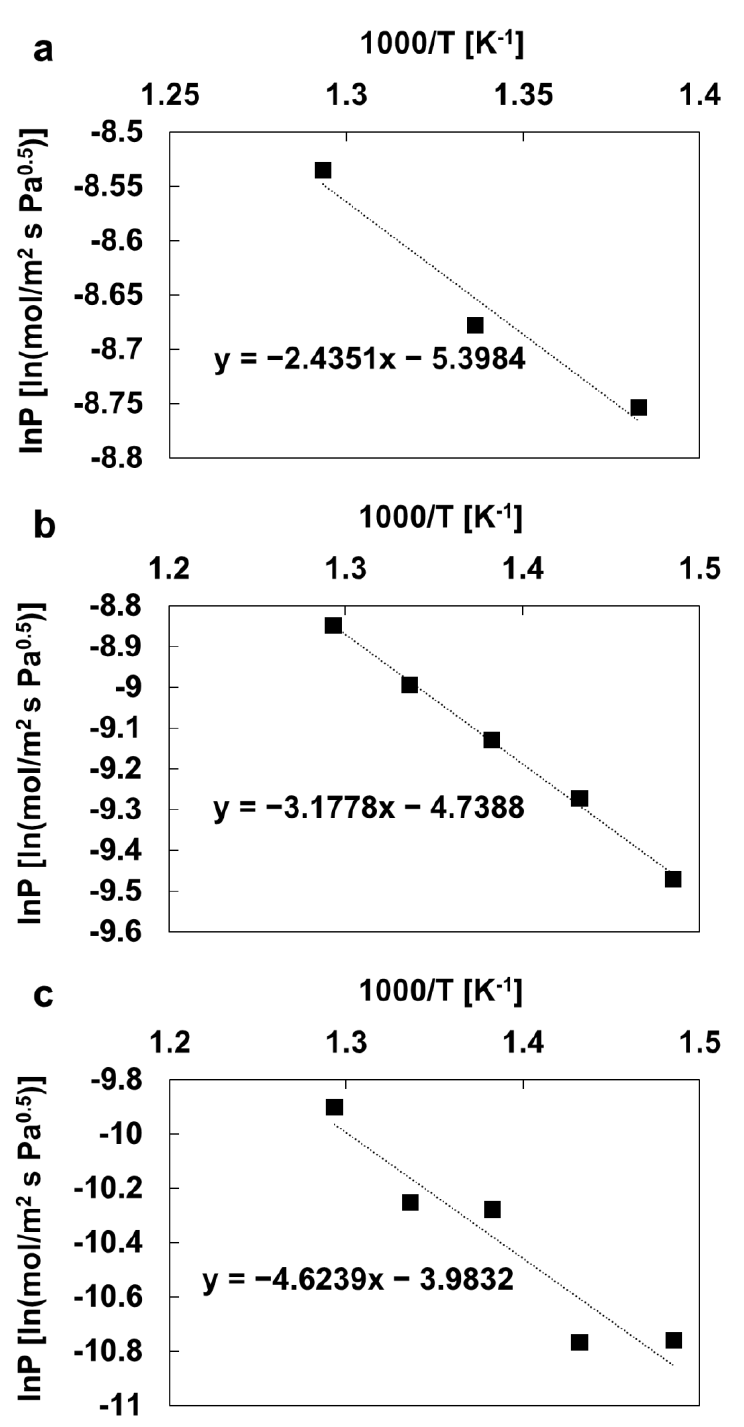
Figure 9. lnP vs. 1000/T of H 2 permeation test for ( a ) the Pd(ELP)/Ta disk, ( b ) the Pd(ELP)Cu(SPT)/Ta disk, and ( c ) the PdCu(co-SPT)/Ta membranes.